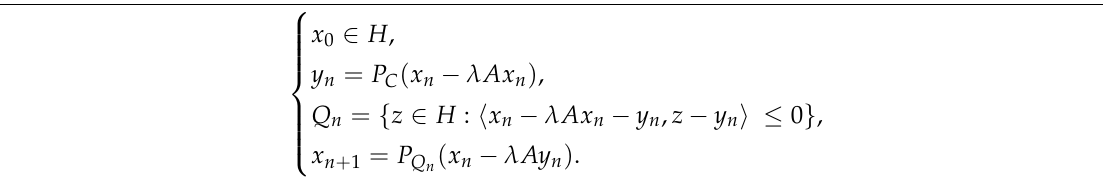
Algorithm 2: Subgradient Extragradient Method